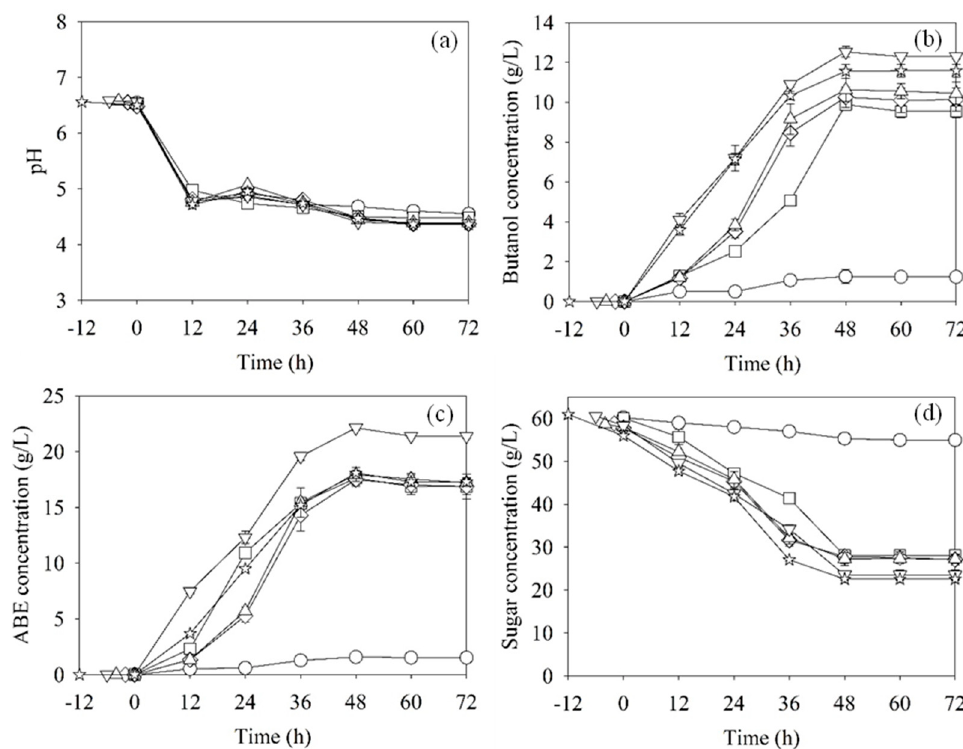
)). In the (cid:35) ), 4 ( (cid:52) ), 6 ( (cid:53) ) and 12 h ( (cid:73) ) of (cid:51)